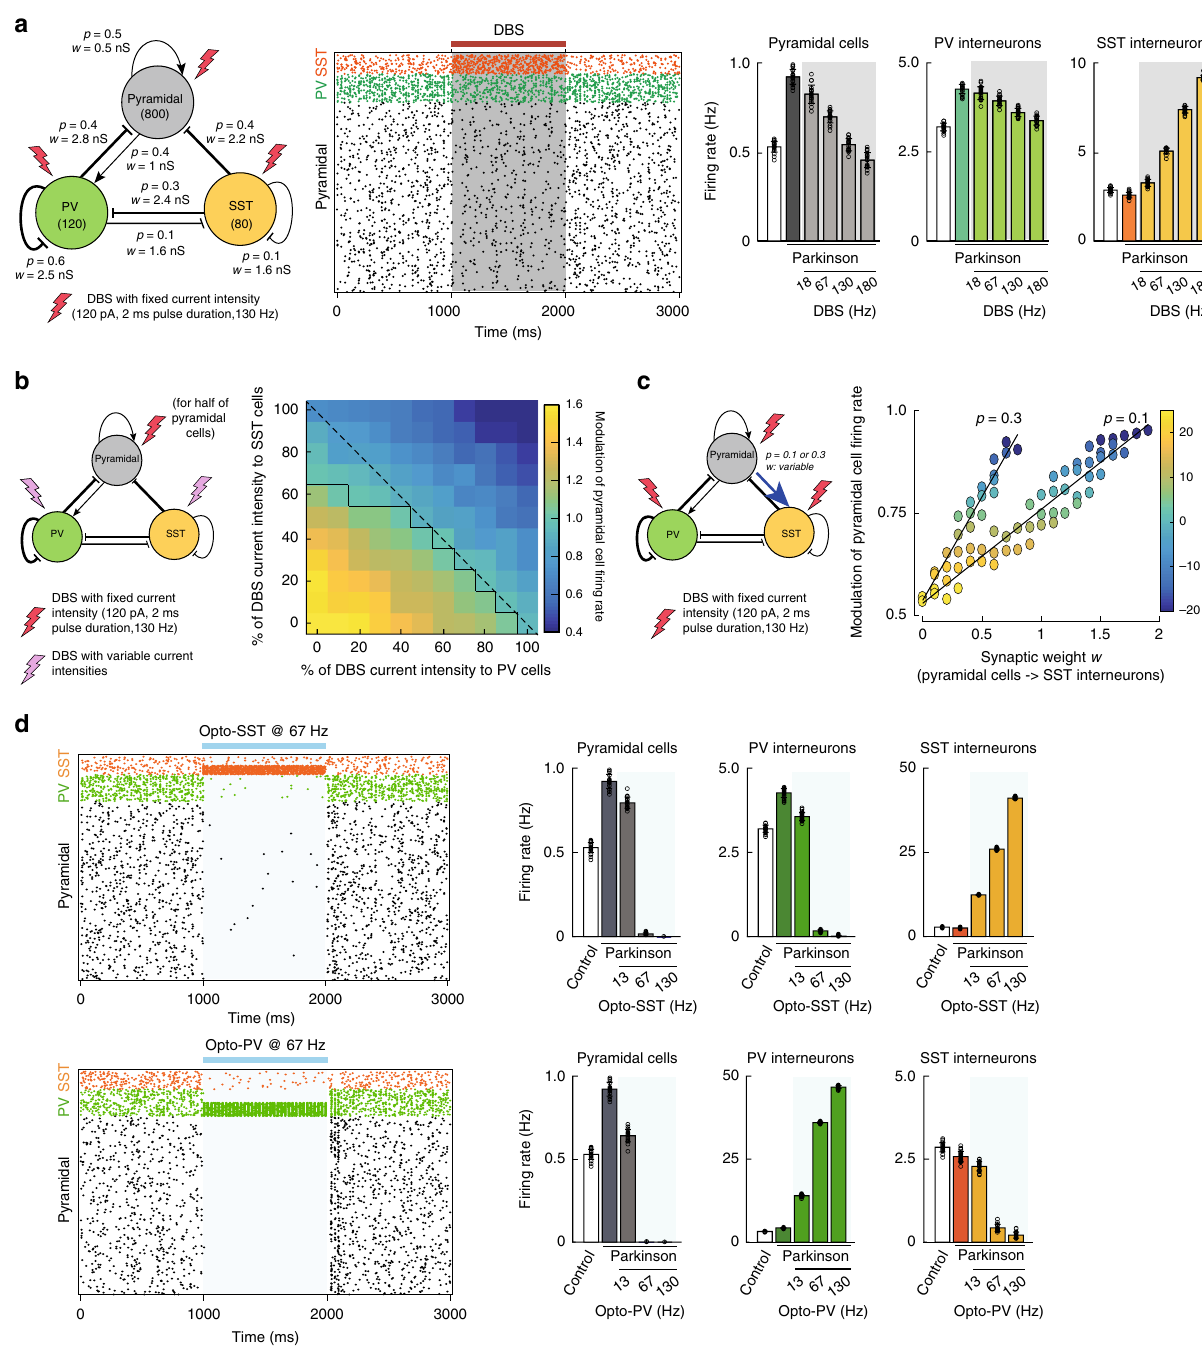
Fig. 6 A simpli fi ed M1 model recapitulates DBS effects on cortical activity. a Model architecture (left) of layer V motor cortex, with population-speci fi c connection probability p and synaptic weight w (arrow: excitatory, bar: inhibitory). Raster plot (center) before, during, and after DBS. Population fi ring rate (mean ± SD) across different conditions and for varying DBS frequencies (right). All fi ring rates are signi fi cantly ( p < 0.001) different from those observed in the parkinsonian condition ( p < 0.001, n = 20 independent simulations of 1000 ms, with different intrinsic noises and connectivity patterns). b Average fi ring rate of pyramidal cells relative to the parkinsonian condition ( n = 20 independent simulations) as a function of the percentage of DBS